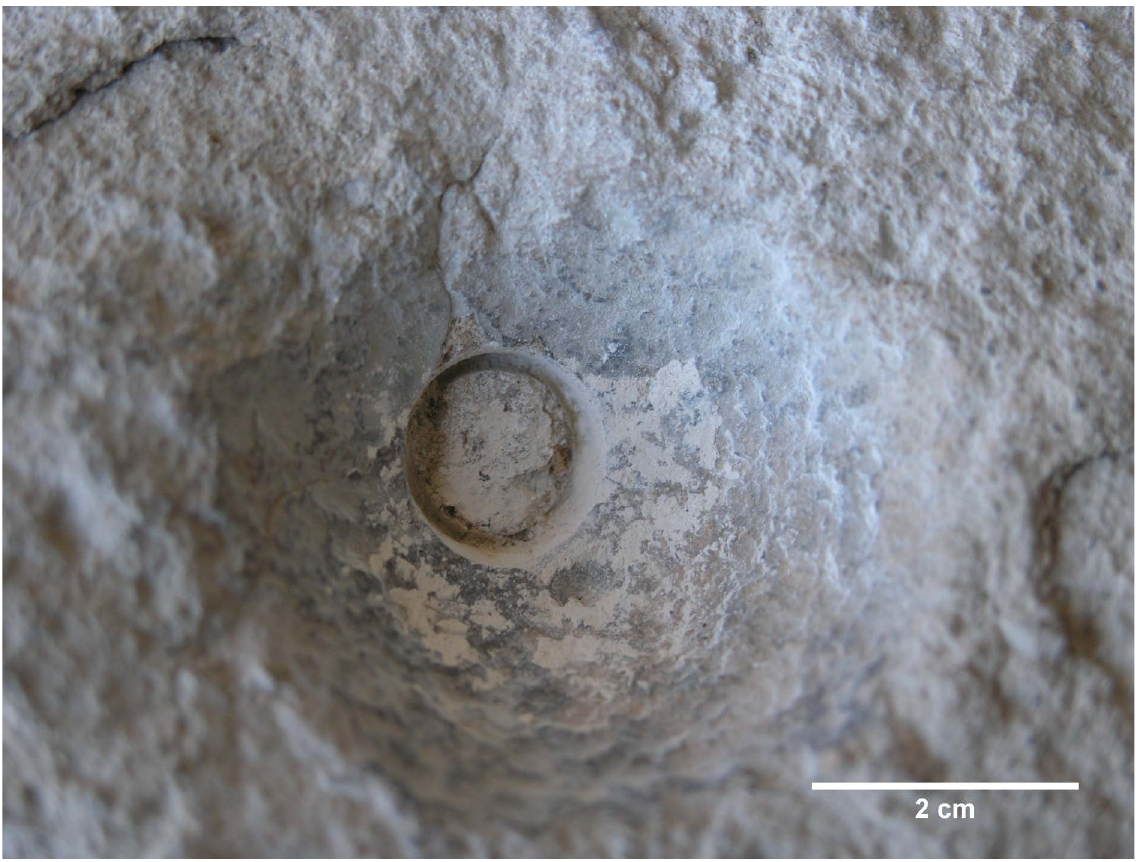
Figure 6. Sampled RMP-5 cupule. Scale is